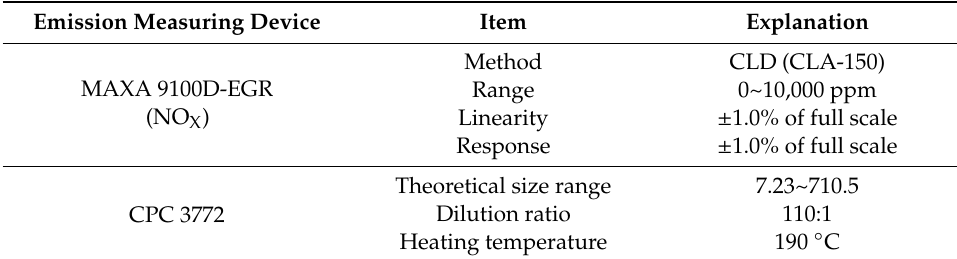
Table 2. Specifications of emission bench (MAXA 9100D-EGR, HORIBA) and condensation particle counter (CPC, 3772,